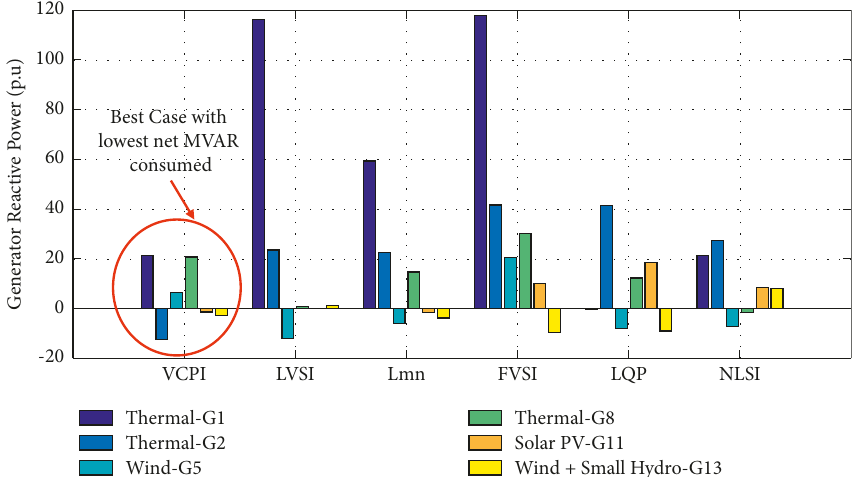
Figure 8: SC-1 Reactive power generation from the different generators.